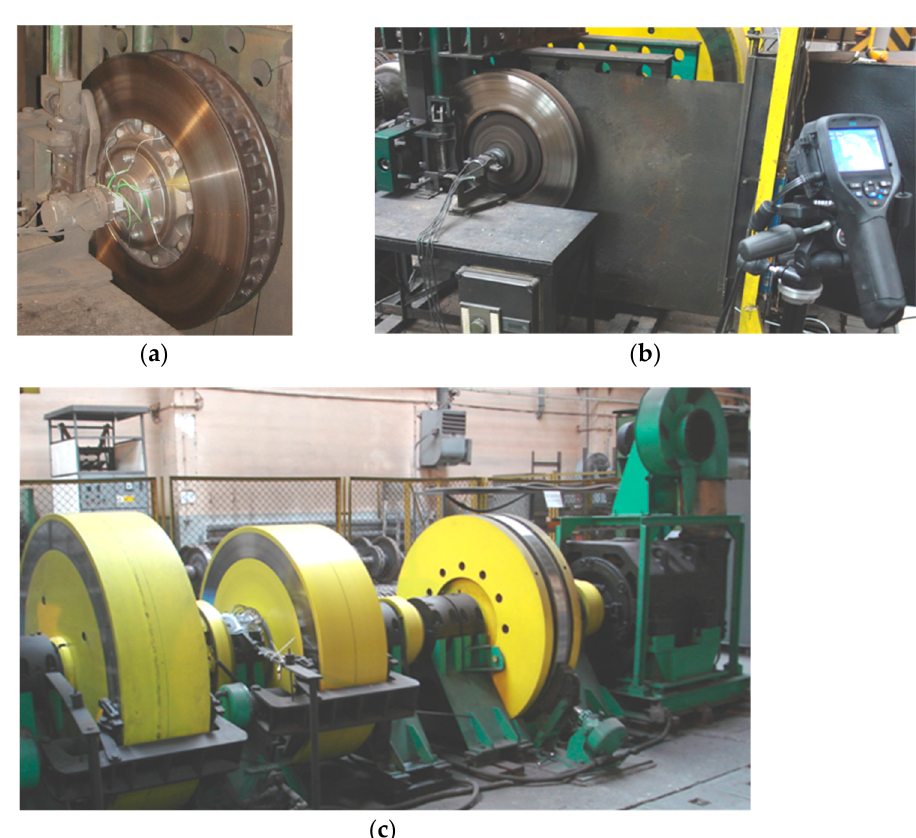
Figure 1. Railroad disc brake testing stand: ( a ) view to the working part of the brake stand with rotating masses, ( b ) view to the tested brake disc with thermovision measurement, ( c ) view of the stand.